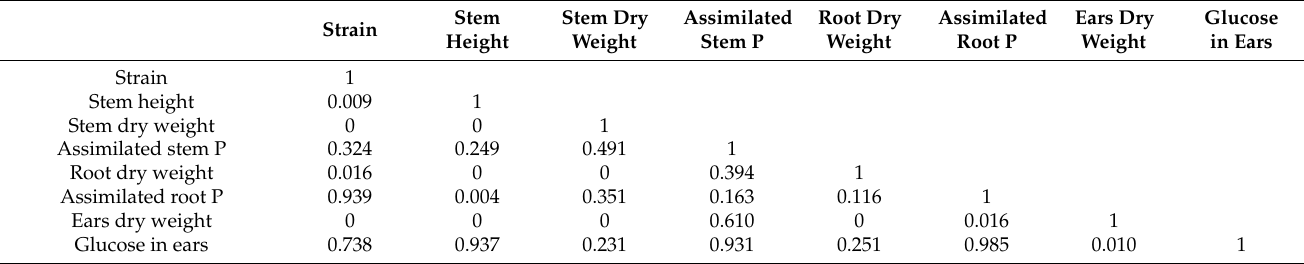
Table 4. Statistical correlation between some of the variables analyzed in the pot experiment. The results shown correspond to Spearman’s correlation coefficient. Those data with statistical significance ( p value < 0.05) are highlighted in